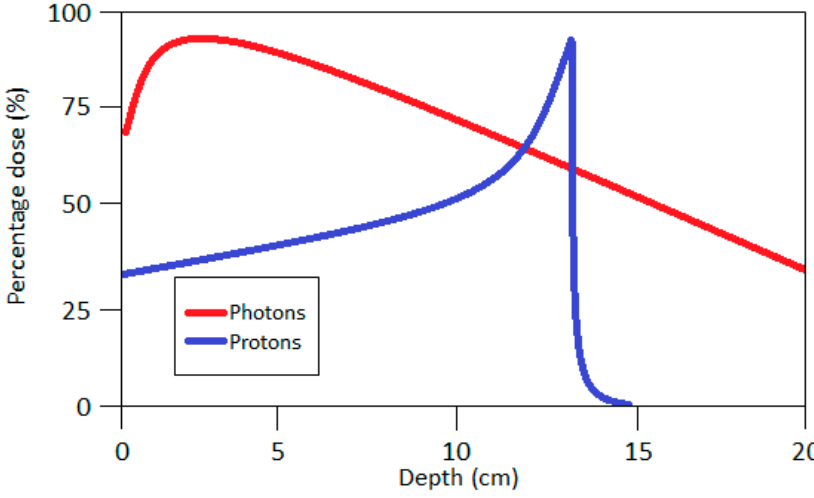
Figure 4. Dose distribution of photons and protons.